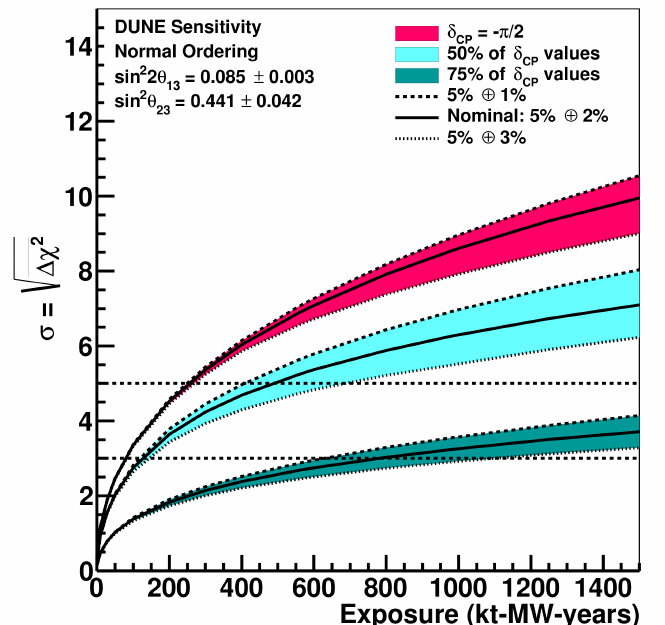
Figure 10. CP violation sensitivity for DUNE as a function of the exposure (see text). The width of the band corresponds to the difference in sensitivity between ν e signal normalization uncertainty of 1% and 3%. The nominal uncertainty of 5% on the ν µ disappearance mode and 2% on the ν e appearance mode is shown as the solid line. The three curves show the significance when δ CP = − π /2 and the minimum significance for 50% and 75% of true δ CP values (CP